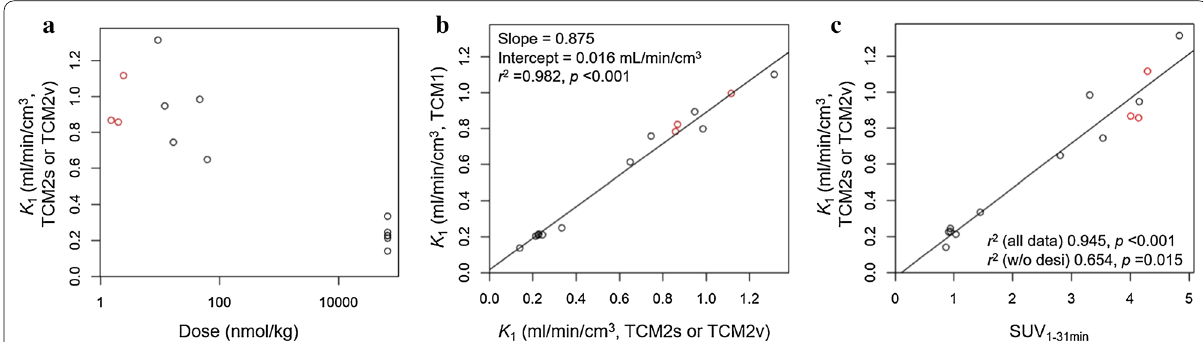
Fig. 7 a Dose dependency and desipramine sensitivity of K 1 in the TCM2s and TCM2v. Dose of combined [ 11 C]mHED and metaraminol up to 61.6 nmol/kg. The highest dose in the plot (66 µmol/kg) corresponds to 20 mg desipramine HCl to fully saturate NET. b K 1 of TCM1 correlated with K 1 of the more complex TCM2s or TCM2v. Slope, intercept, r 2 , and p as indicated. c K 1 of the TCM2s and TCM2v correlated with SUV 1–31 min . SUV 1–31 min may serve as a surrogate parameter for NET transport activity. r 2 and p for the data including scans with desipramine ("all data", regression lines) and without desipramine scans ("w/o desi"), as indicated. Note that for the estimation of K 1 , 11 of the 14 scans were analysed with a surrogate input function. Red symbols, scan with an input